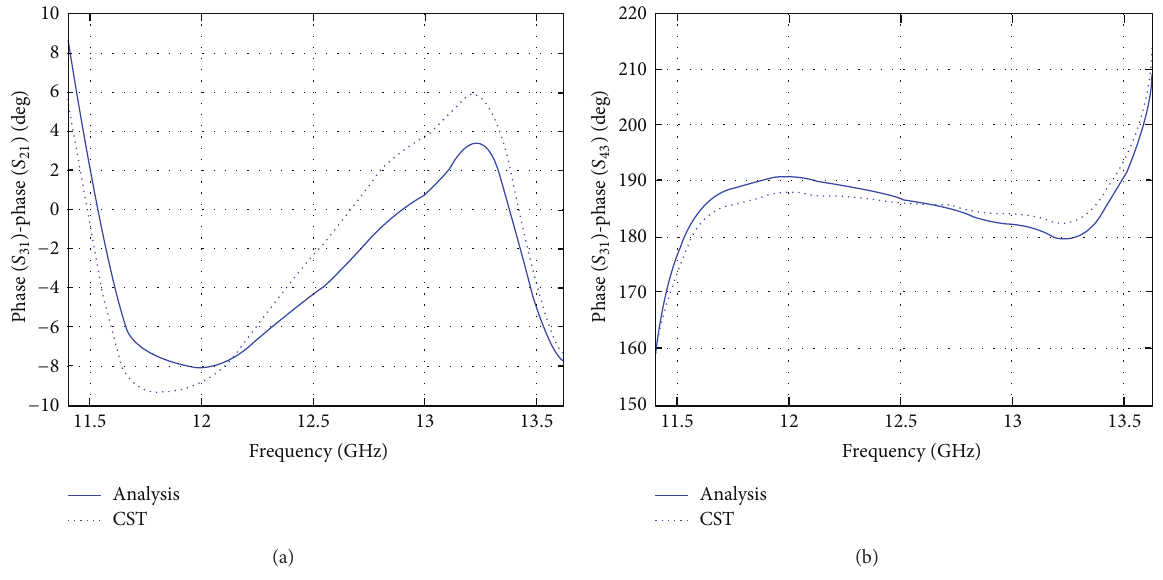
Figure 4: Phase responses of the SIW rat-race coupler: (a) in-phase response and (b) out-of-phase response.